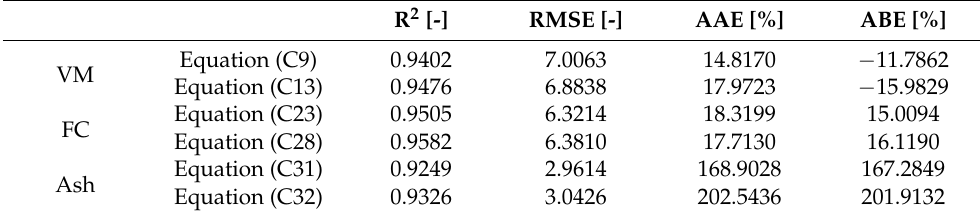
Table 6. Summary of validation results of VM, FC, and Ash.